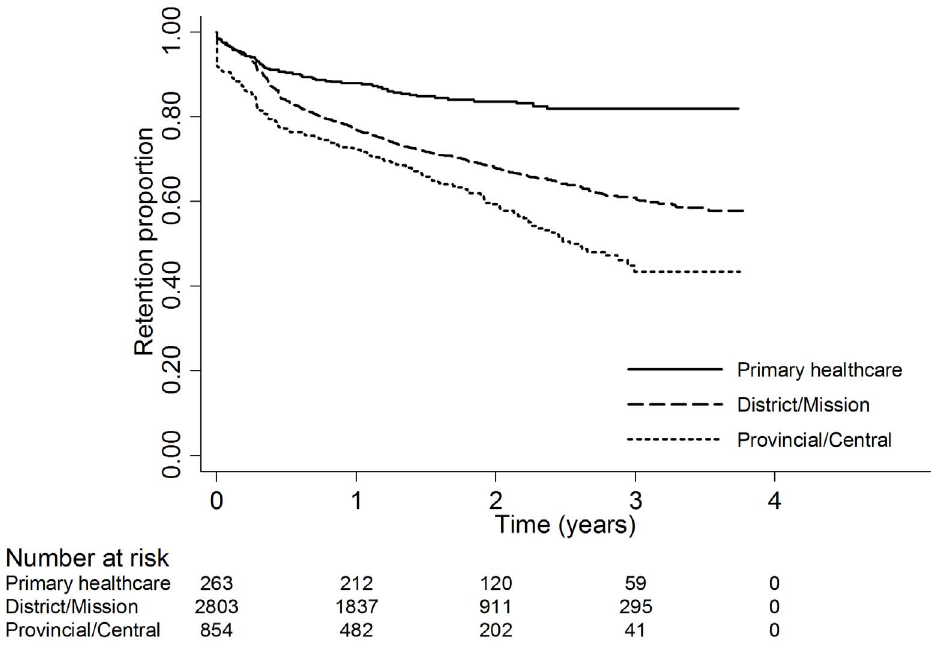
Figure 2. Retention stratified by level of healthcare.